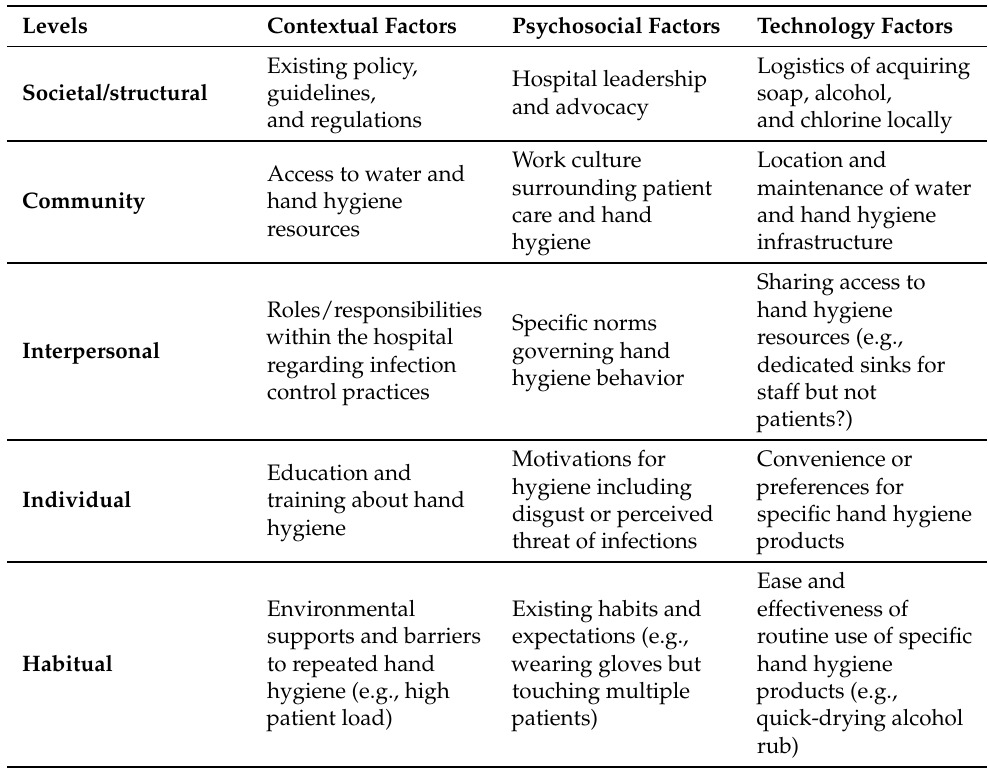
Table A1. Integrated Behavioral Model for Water, Sanitation, and Hygiene (IBM-WASH) [40] adapted for Liberia hospital hand hygiene qualitative assessment,